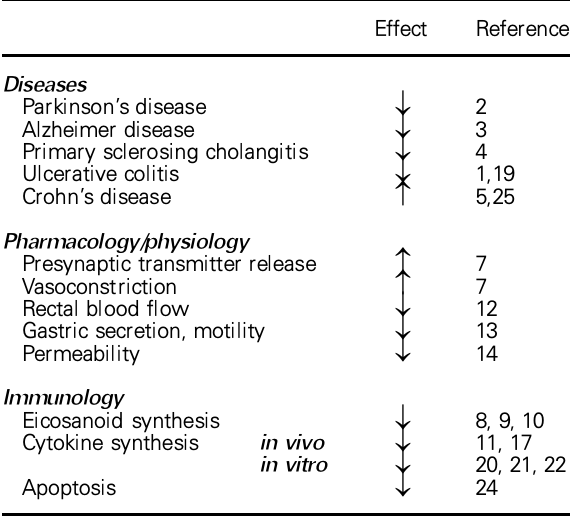
Table 1. Main effects of